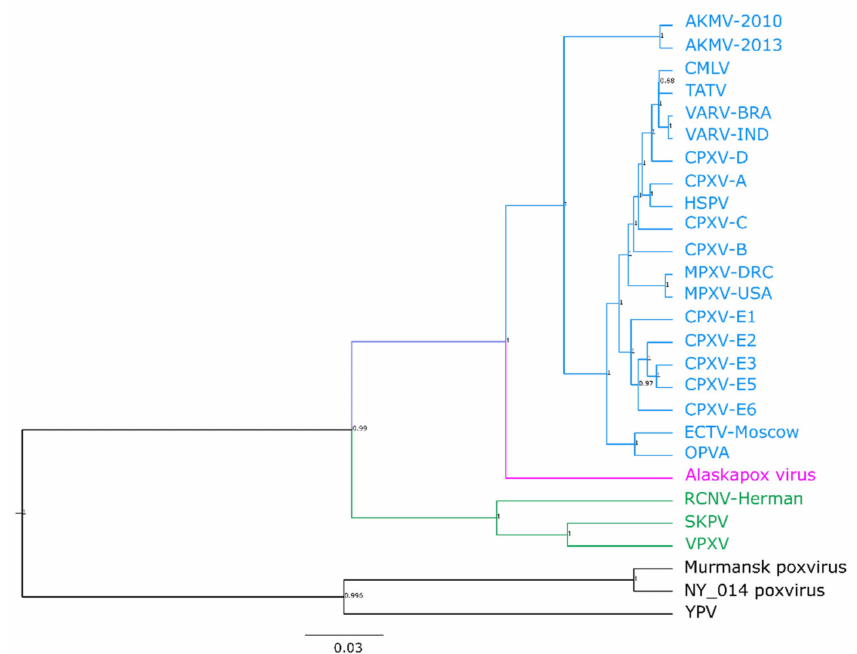
Figure 1. Phylogenetic analysis of the conserved central region of the Alaskapox virus (AKPV) genome with representative OPXVs, Murmansk poxvirus, NY_014 poxvirus, and Yoka poxvirus (YPV). Twenty-seven poxvirus sequences (Table S1) were aligned using MAFFT. Old World OPXVs are highlighted in blue; New World OPXVs are highlighted in green; AKPV is highlighted in pink. Phylogenetic tree was estimated using BEAST v. 2.5.1 using the GTR + G + I model under a relaxed lognormal molecular clock. Posterior probability is shown next to each